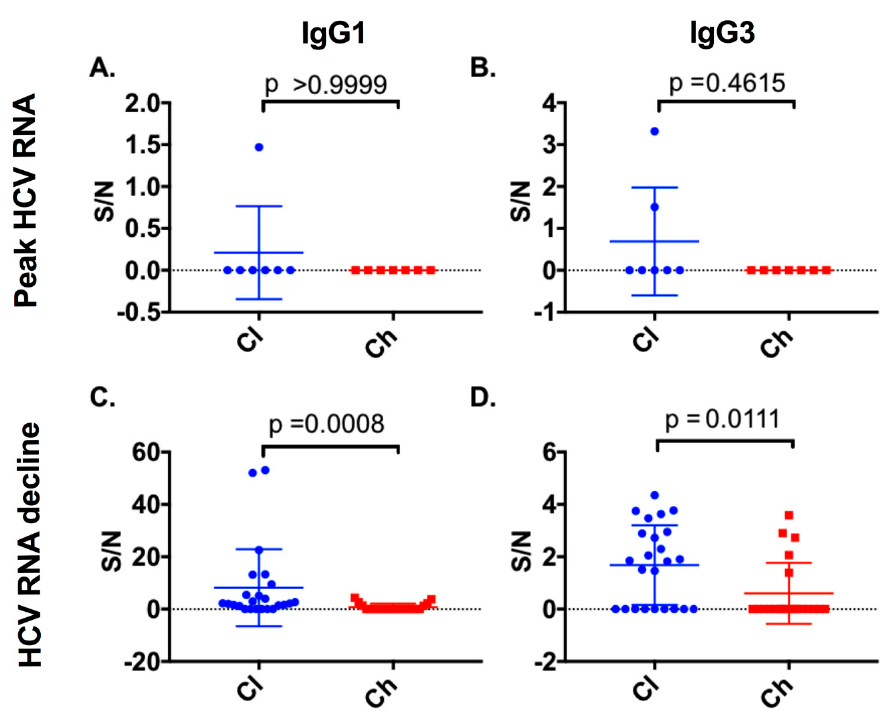
Figure 6. Anti-E2 IgG1 and IgG3 responses were examined at the peak HCV RNA time point and at the initial decline in viral load for both clearer and chronic progressor subjects. Anti-E2 IgG subclass responses at the peak HCV RNA time points were compared for anti-E2 IgG1 ( A ) or anti-E2 IgG3 ( B ). Additionally, time points where initial HCV RNA decline occurred were compared for clearers and chronic progressors for anti-E2 IgG1 ( C ) and anti-E2 IgG3 ( D ) responses.